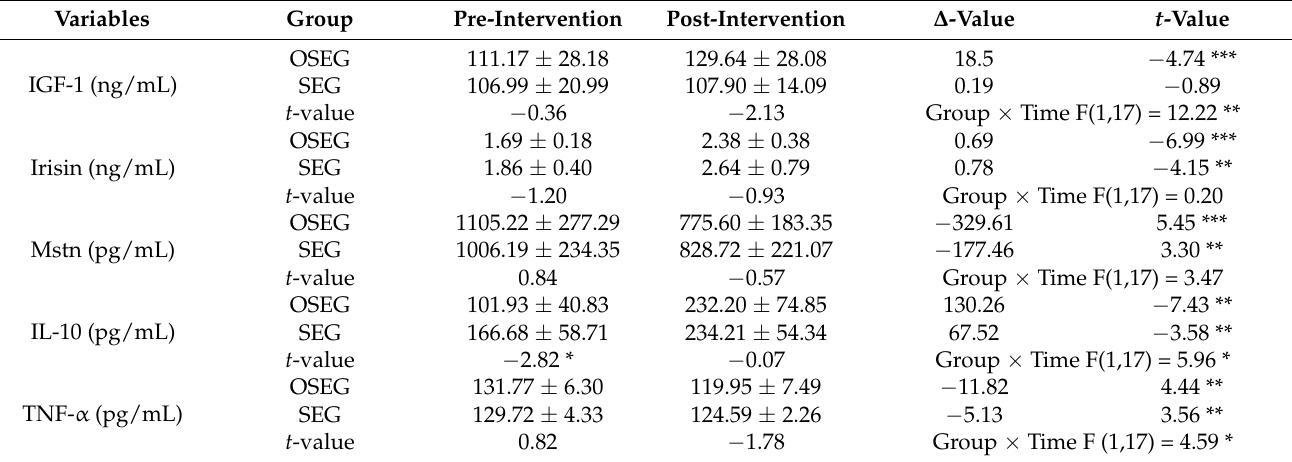
Table 4. Serum myokine